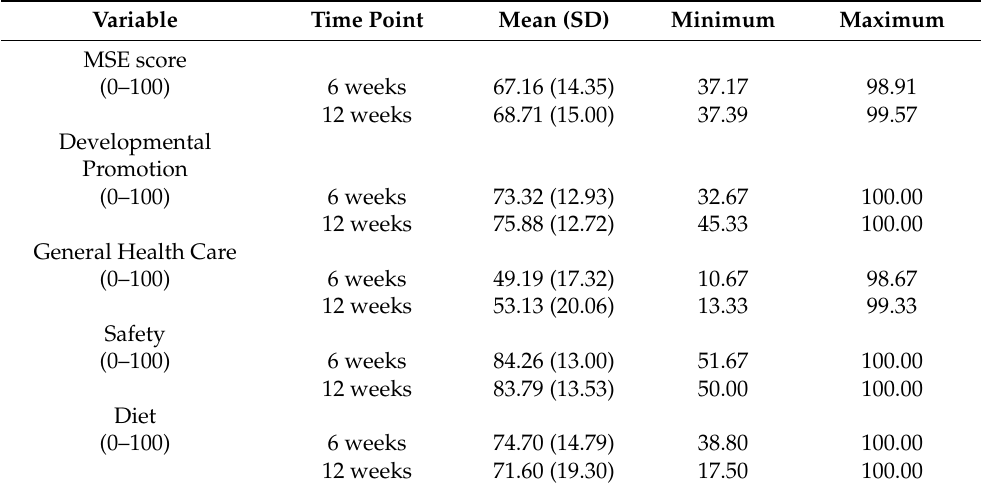
Table 3. The mean scores of SICS and its four dimensions at 6 ( n = 544) and 12 ( n = 435) weeks postpartum.